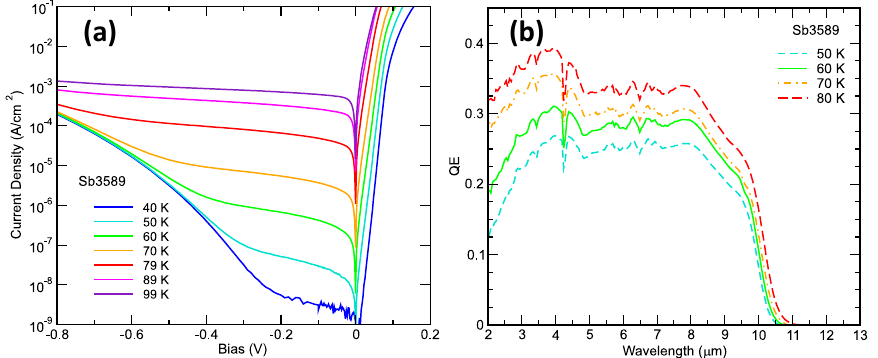
Figure 7. ( a ) Dark current density as a function of applied bias, measured at several temperatures, and ( b ) backside illuminated spectral QE, for a pn-CBIRD detector fabricated from sample Sb3589.